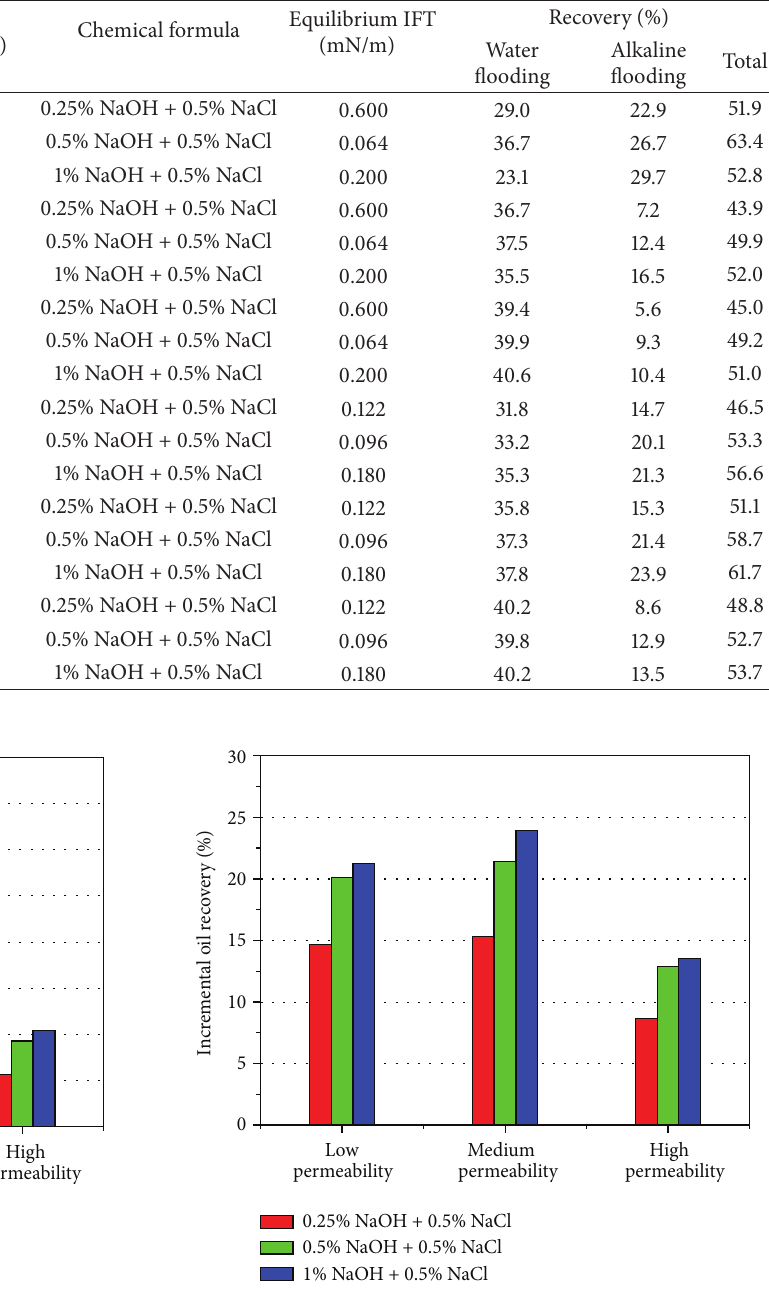
Figure 3: Alkaline flooding performance of Zhuangxi heavy oil.